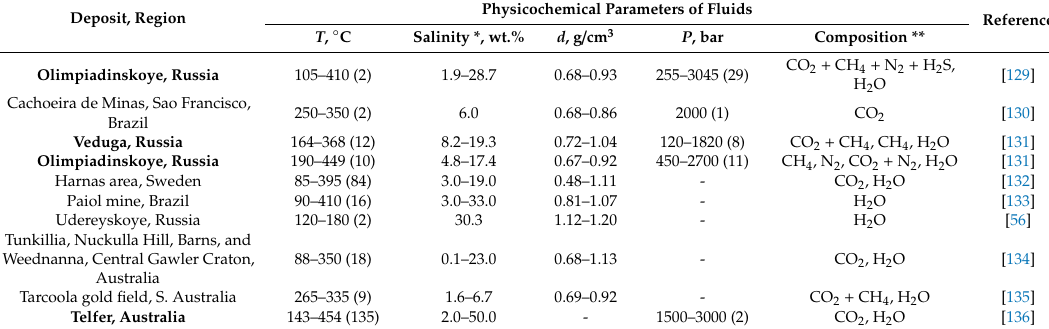
Table 5. Parameters of ore-forming fluids of Meso- and Neoproterozoic gold deposits. Deposit, Region